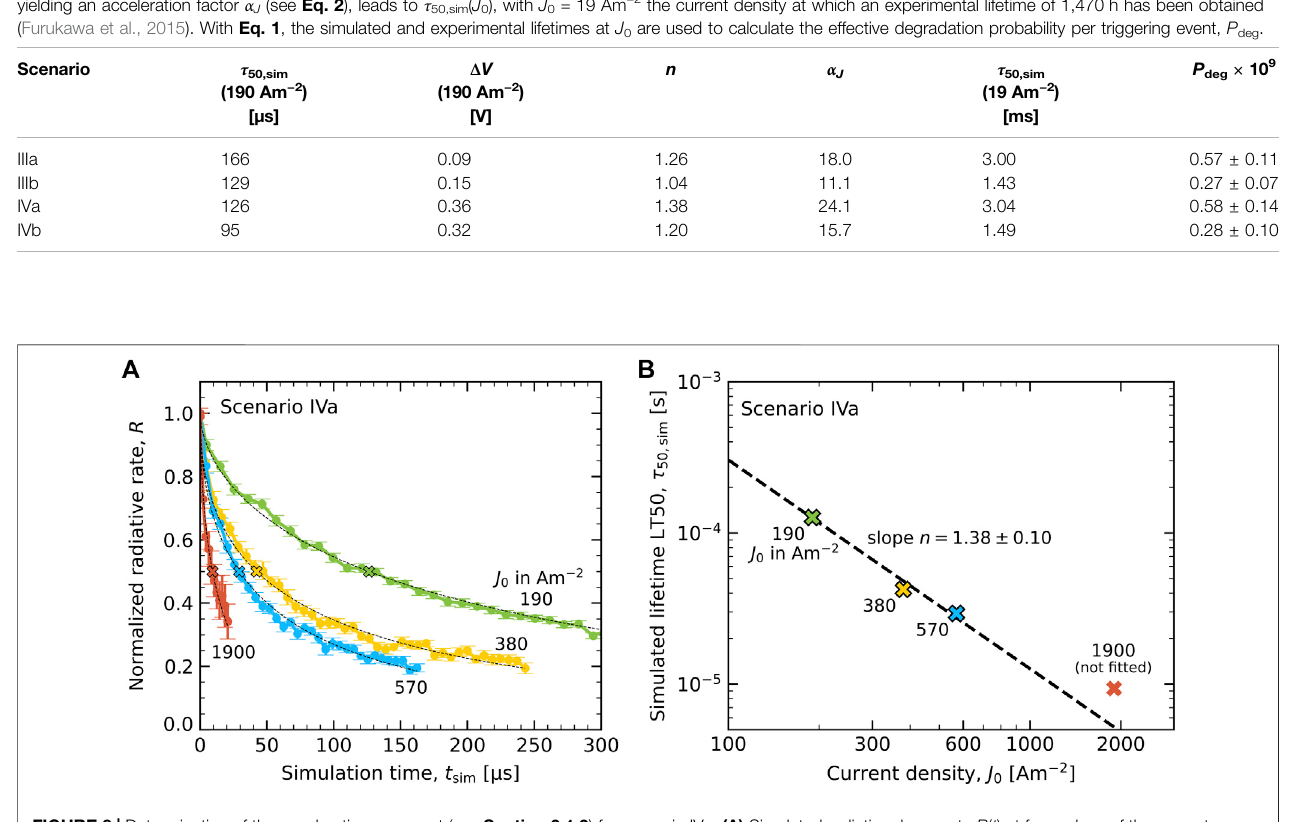
FIGURE 8 | Determination of the acceleration exponent (see Section 3.1.3 ) for scenario IVa. (A) Simulated radiative decay rate R ( t ) at four values of the current density, normalized to the equilibrated value of R in the pristine state. Dashed curves give stretched exponential fi ts to the simulation results. Crosses mark the